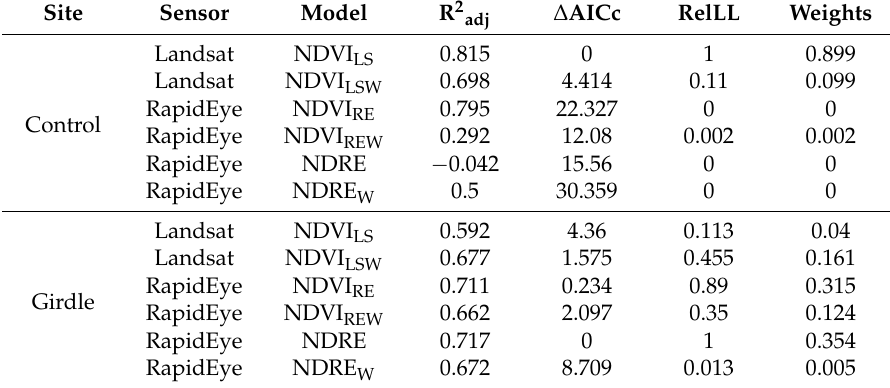
Table 4. Model performance statistics for only year 2011 of the experiment, a significant drought year. See Table 1 for a description of model names. R 2 adj is the adjusted R 2 , ∆ AICc is the difference in model AICc relative to the lowest scoring model, RelLL is the relative log likelihood, or how likely it is that each model is actually the best, and Weights is a list of the AICc weights for each